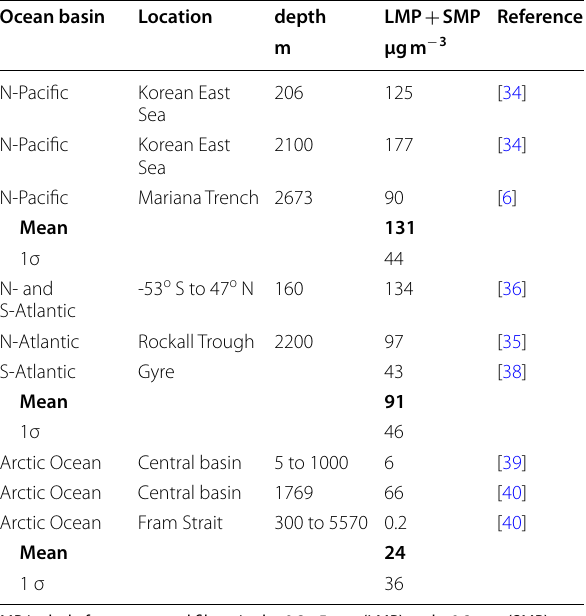
Table 1 Subsurface ocean microplastics (MP) observations